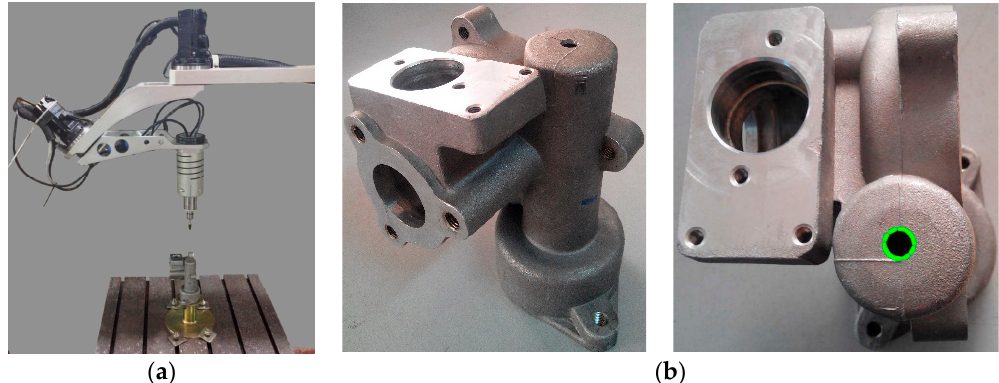
Figure 8. Experimental platform and experimental object: ( a ) experimental platform of improved robot manipulator; ( b ) overall appearance of booster housing.